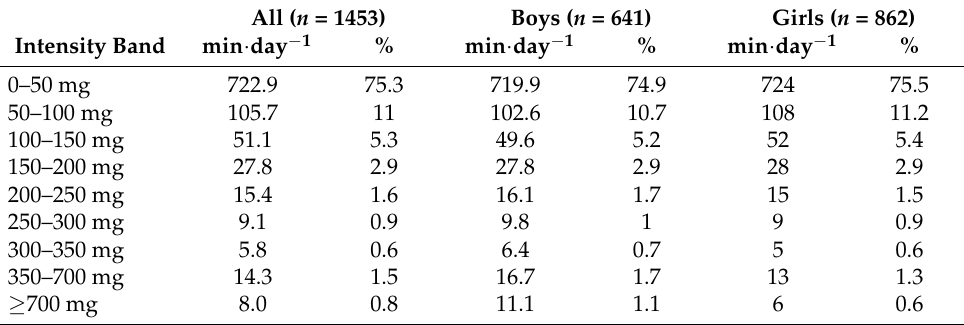
Table 2. Geometric means of the time spent in the intensity spectrum bands. All ( n = 1453) Boys ( n = 641) Girls ( n = 862)